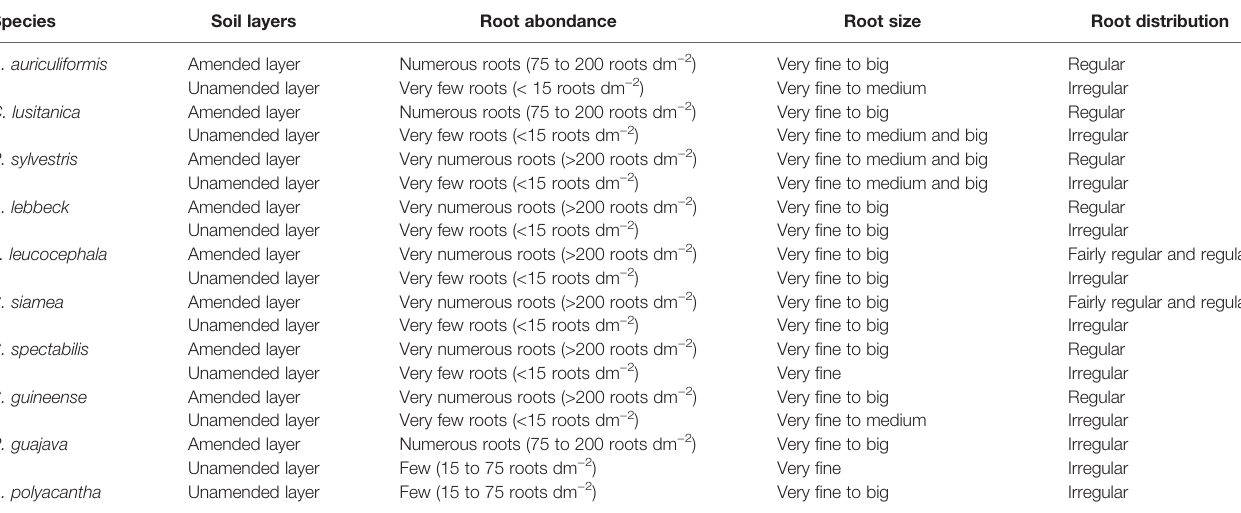
TABLE 4 | Characteristics of roots according to tree species in amended and unamended layers.